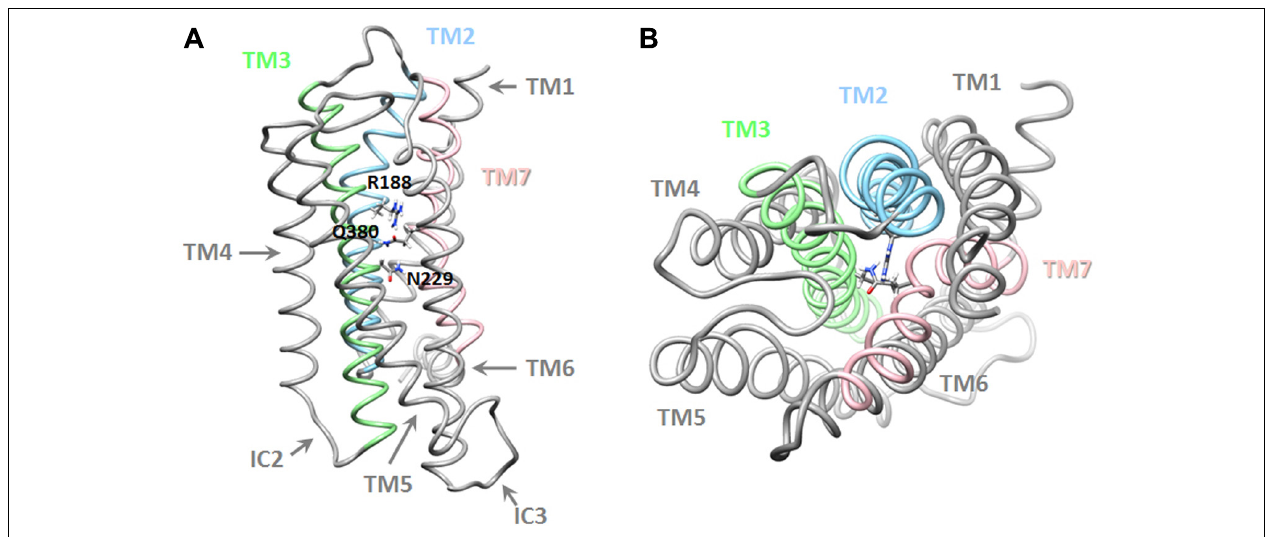
FIGURE 3 |Three-dimensional model of the transmembrane domains of theVPAC 1 receptor. Lateral (A) and top (B) view of a working model of human VPAC 1 receptor,TM, and residues identified as important for receptor stabilization are also labeled. Details regarding modeling procedure are described in Chugunov etal.